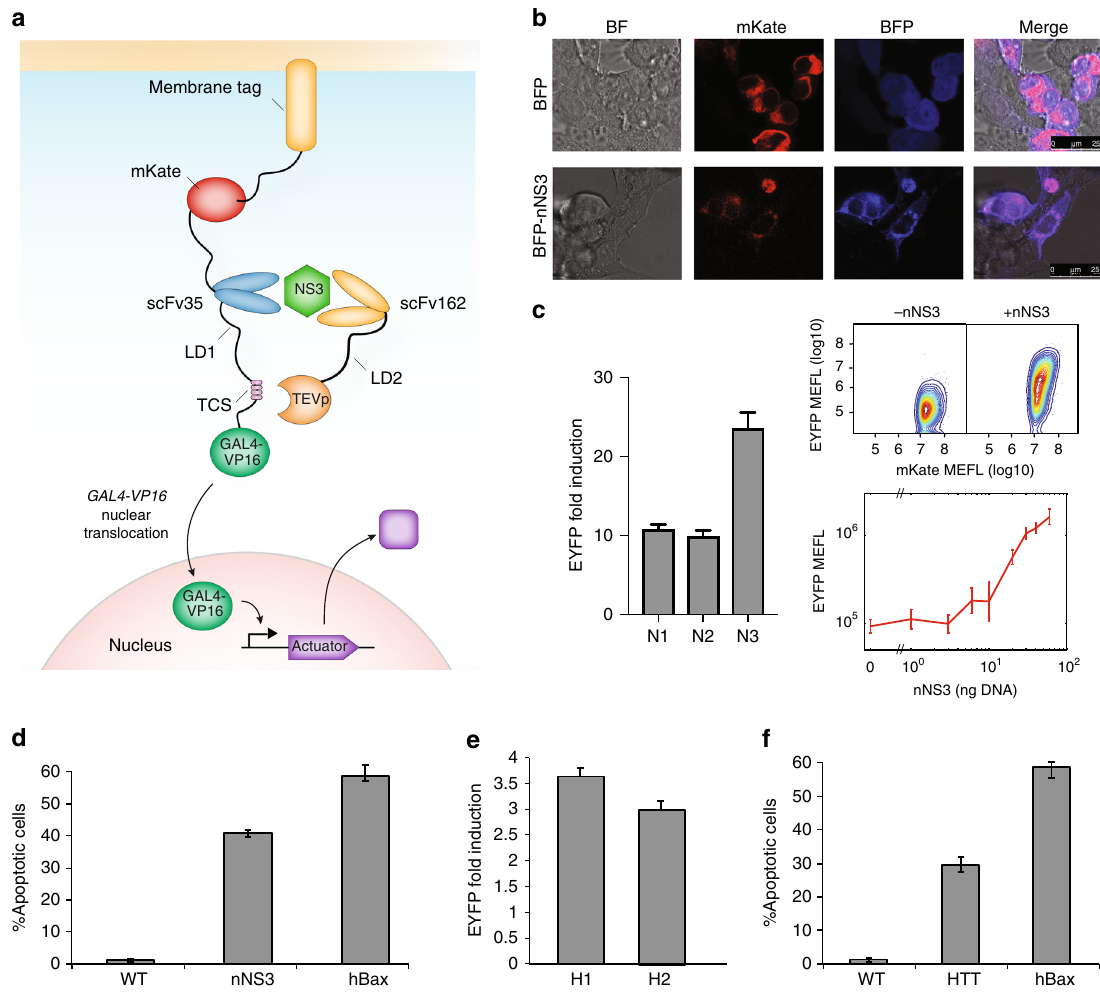
Fig. 1 Protein sensing-actuation devices in mammalian cells. a Schematics of the protein sensor. One intrabody is anchored to the membrane and fused at the N-terminus to mKate fl uorescent tag and at the C-terminus to the TEV cleavage site (TCS) and to a GAL4-VP16 transcriptional activator. A second intrabody is fused to the TEV protease (TEVp). Interaction of the intrabodies with the target protein results in TEVp-mediated release of membrane- anchored GAL4-VP16 and output activation. b Co-localization of BFP-nNS3 and mKate-scFv35-antibody in HEK293FT cells. Confocal images (×63) indicate co-localization when BFP is fused to nNS3 in HEK293FT cells (scale bar = 25 µ m). Non-fused BFP was used as control and show diffused cellular localization. c Best performing variants of intrabody-TCS/intrabody-TEVp combinations (N1: scFv35-LD15-TCS(L)/TEVp-LD15-scFv162, N2: scFv35-LD0- TCS(L)/DD-scFv162-LD15-TEVp, N3: scFv35-LD0-TCS(L)/TEVp-LD0-scFv162) for nNS3 device. EYFP data shows fold induction and standard deviation using molecules of equivalent fl uorescein (MEFL) of EYFP for cells expressing >1 × 10 7 MEFL of transfection marker mKate. n = 3 independent technical replicates. Right-top inset: Two-dimensional fl ow cytometry plots for the best variant (N3) in the absence and presence of nNS3. Right-bottom inset: EYFP MEFL as function of the concentration of transfected DNA encoding nNS3 for the N3 variant of the device. d Selective cell death induced by pro-apoptotic hBax-N3 variant in cells expressing nNS3 was determined by Paci fi c-Blue conjugated to Annexin V staining 48 h posttransfection. Constitutively expressed CMV-hBax (labeled as “ hBax ” ) was used as positive control for apoptosis. Data and standard error are of n = 3 independent technical replicates. e Best performing HTT (HDx-1 fi rst exon with poliQ tract) devices (H1: Happ1-LD0-TCS(S)/DD-TEVp-LD0-Vl12.1, H2: Happ1-LD0-TCS(S)/TEVp-LD0-Vl12.1). Data shows EYFP fold induction and standard deviation of EYFP MEFL for cells expressing >3 × 10 7 MEFL of transfection marker mKate. n = 3 independent technical replicates. f Selective cell death induced by hBax apoptotic protein in cells expressing HTT was determined by Paci fi c-Blue conjugated to Annexin V staining 48 h posttransfection. The assay was performed on HTT best performing device (Happ1-LD0-TCS(S)/DD-TEVp-LD0-Vl12.1) using the pro- apoptotic hBax as reporter activated by GAL4-VP16. Constitutively expressed CMV-hBax (labelled as “ hBax ” ) was used as positive control for apoptosis. Data and s.e.m. are of n = 3 independent technical conferred by BFP. When pro-apoptotic gene hBax was incorpo- rated as output, speci fi c induction of apoptosis was achieved in nNS3 expressing cells, demonstrating the device ’ s ability to rewire Fig. 5a – e), at intermediate transfection marker levels cellular fate (Fig. 1d, Supplementary Fig. 6). (10 6 < mKate MEFL < 10 7 ; 60 ng of DNA), EYFP induction was The key parameters of circuit design inferred from the NS3 signi fi cantly higher in BFP-nNS3 than nNS3 expressing device (i.e., fi ne tuning of TEVp expression and af fi nity to cells, while at high transfection marker levels (10 7 < mKate cleavage site) were consequently considered in the development MEFL < 10 8 ) EYFP levels were comparable (Supplementary Fig. 5f). This is perhaps due to a higher stability of the protein of additional sensing-actuator devices. We thus generated